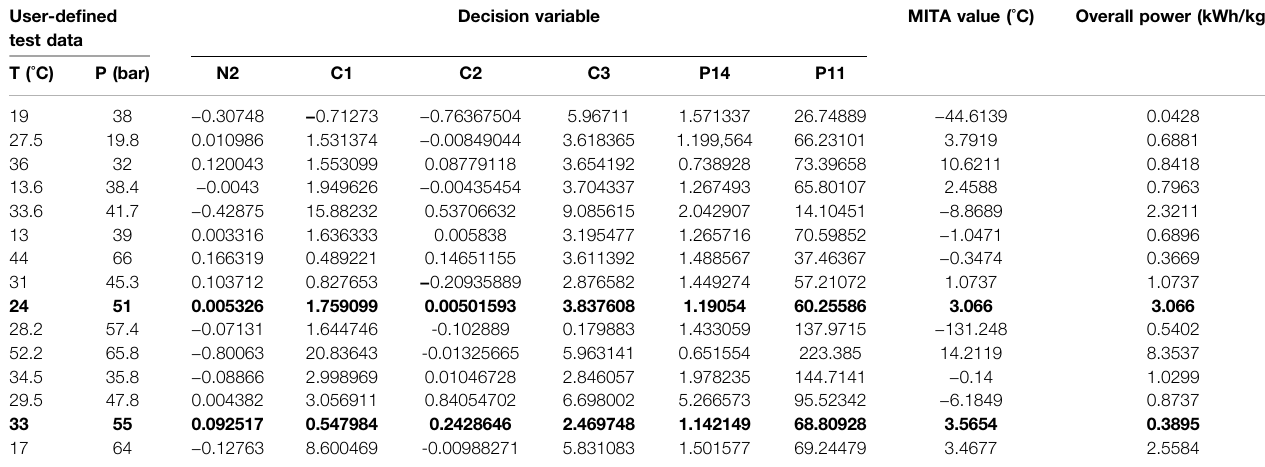
TABLE 13 | BP-ANN performance: estimated decision variables and their corresponding MITA and overall power values against user-de fi ned test data. User-de fi ned test